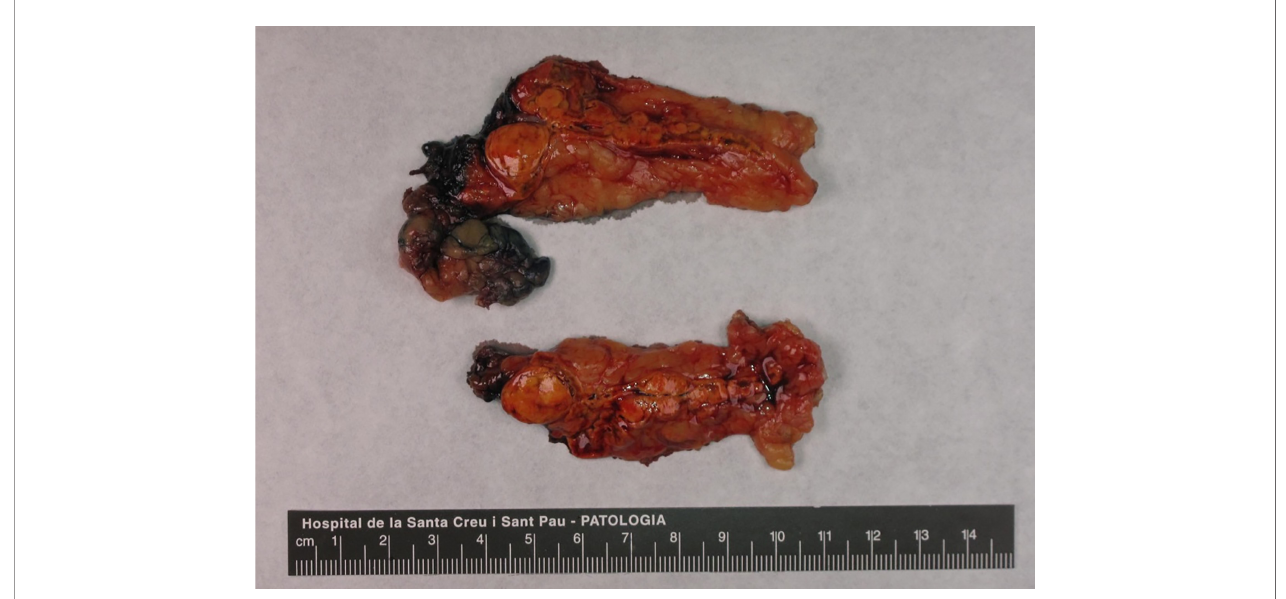
FIGURE 1 | Macroscopic image of the excised adrenal gland (6 × 2 × 2 cm) with a visible multi-nodular pattern. The larger nodule was round, measured 12 mm in diameter and was composed by a bright-yellow soft tissue. Other less de fi ned nodules were